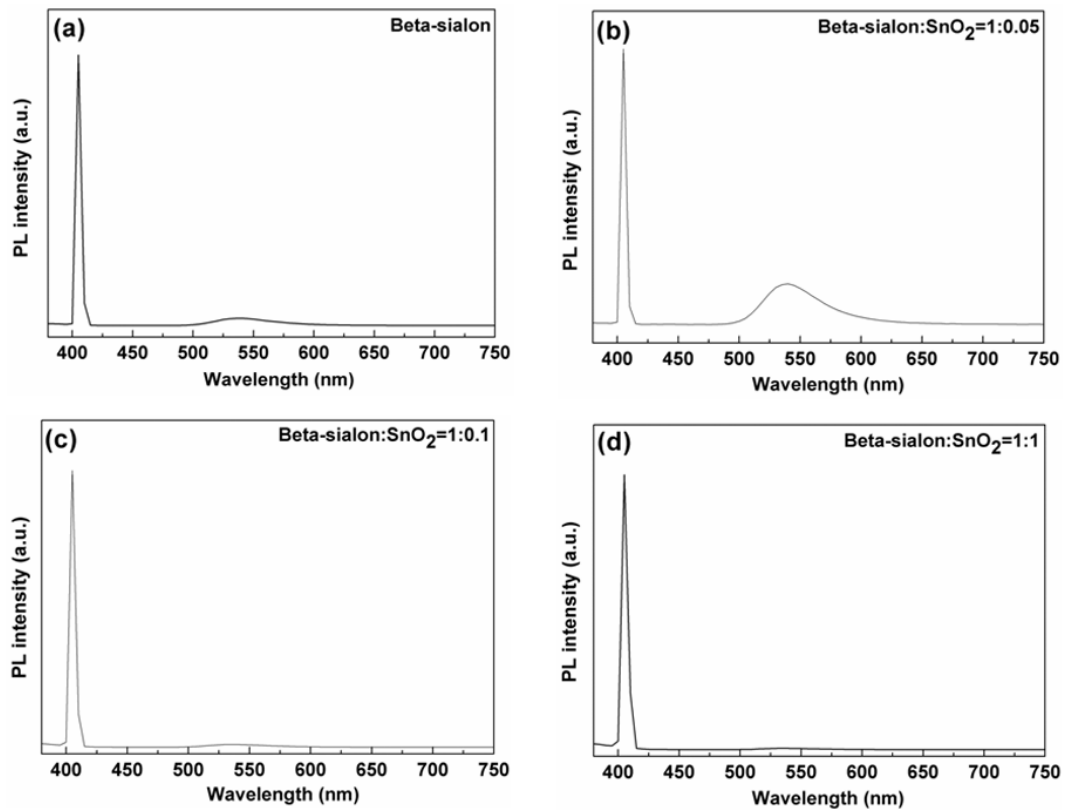
Figure 5. Photoluminescence (PL) spectra of the β -sialon:Eu 2+ deposits, with various mixed amounts (0.05–1 g) of the SnO nanoparticles, prepared by the EPD process at 10 s 2 depositing